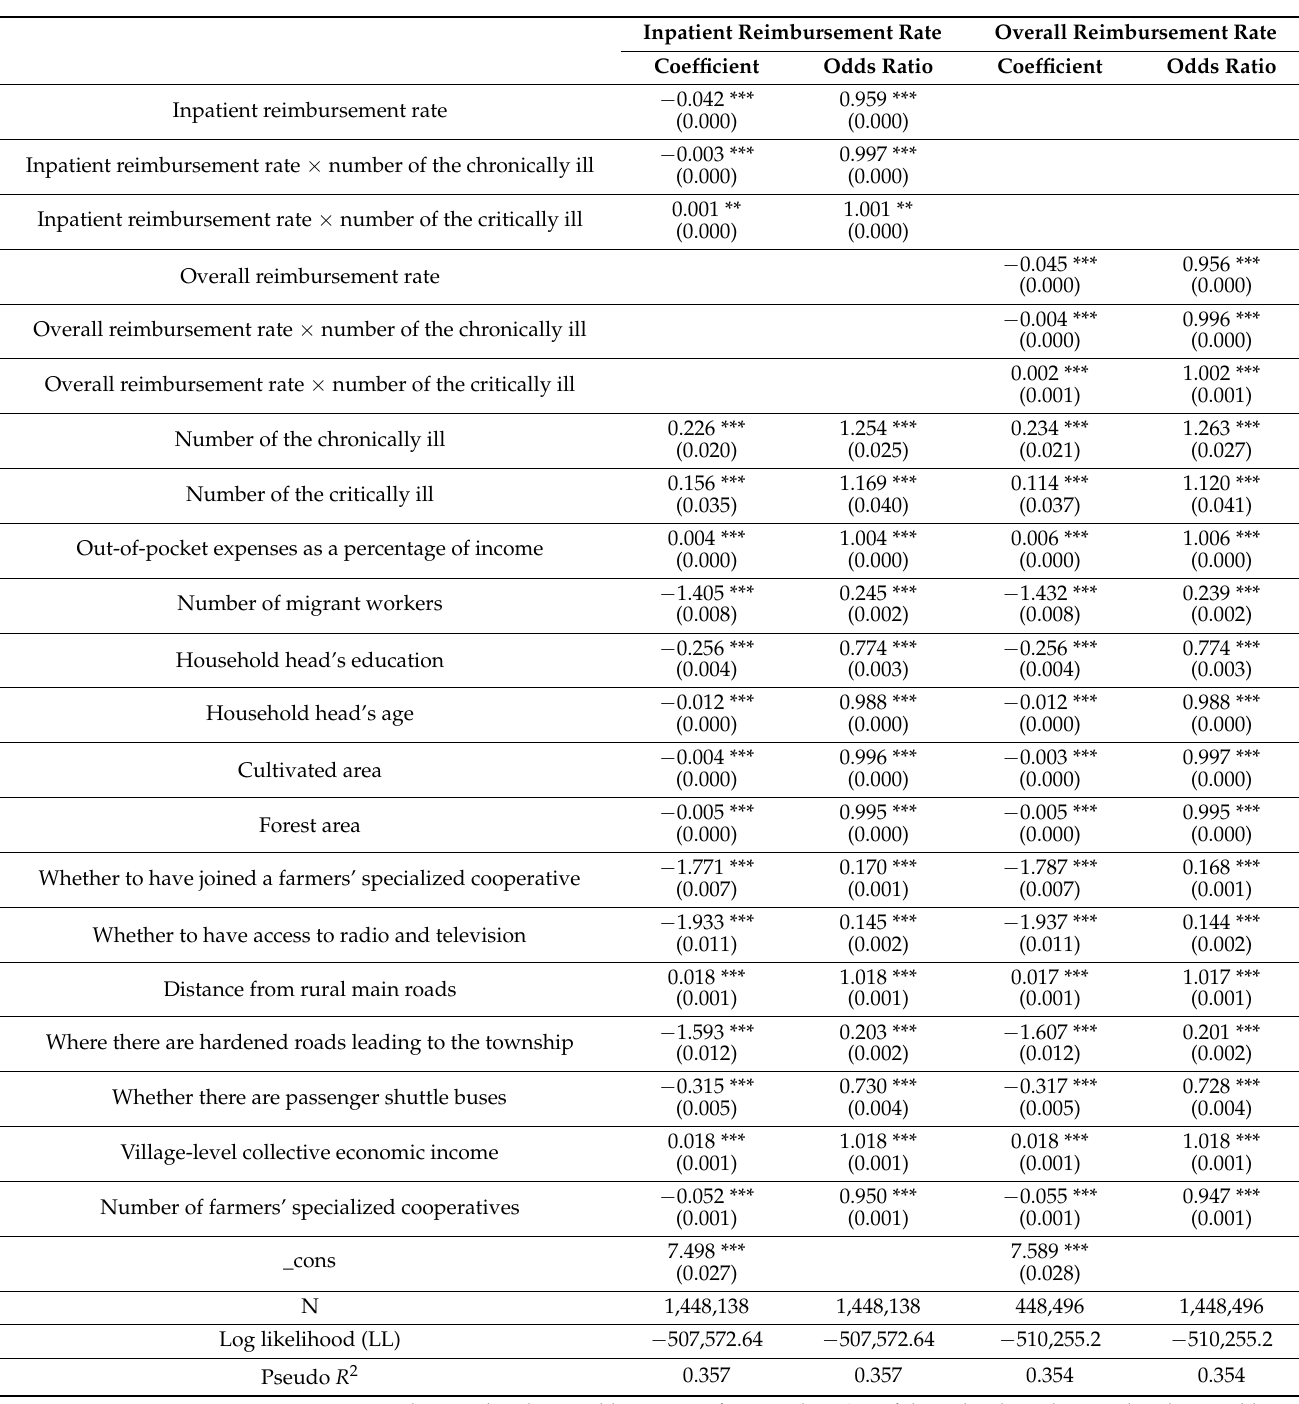
Table 3. Model Estimation